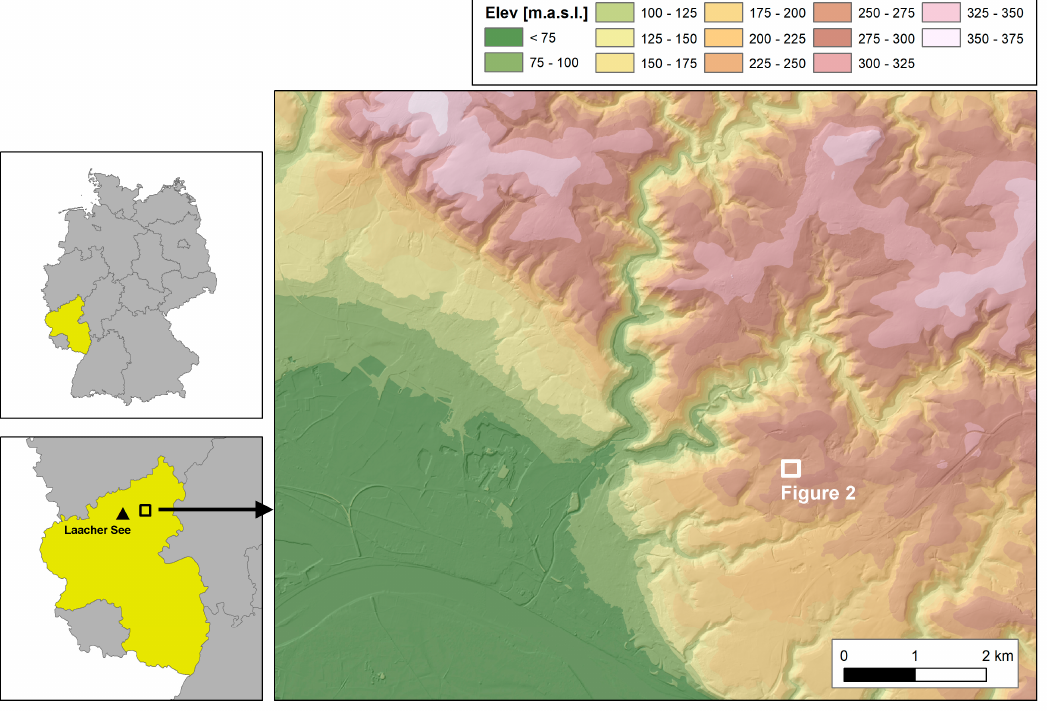
Figure 2. Location of the study area, after [21].